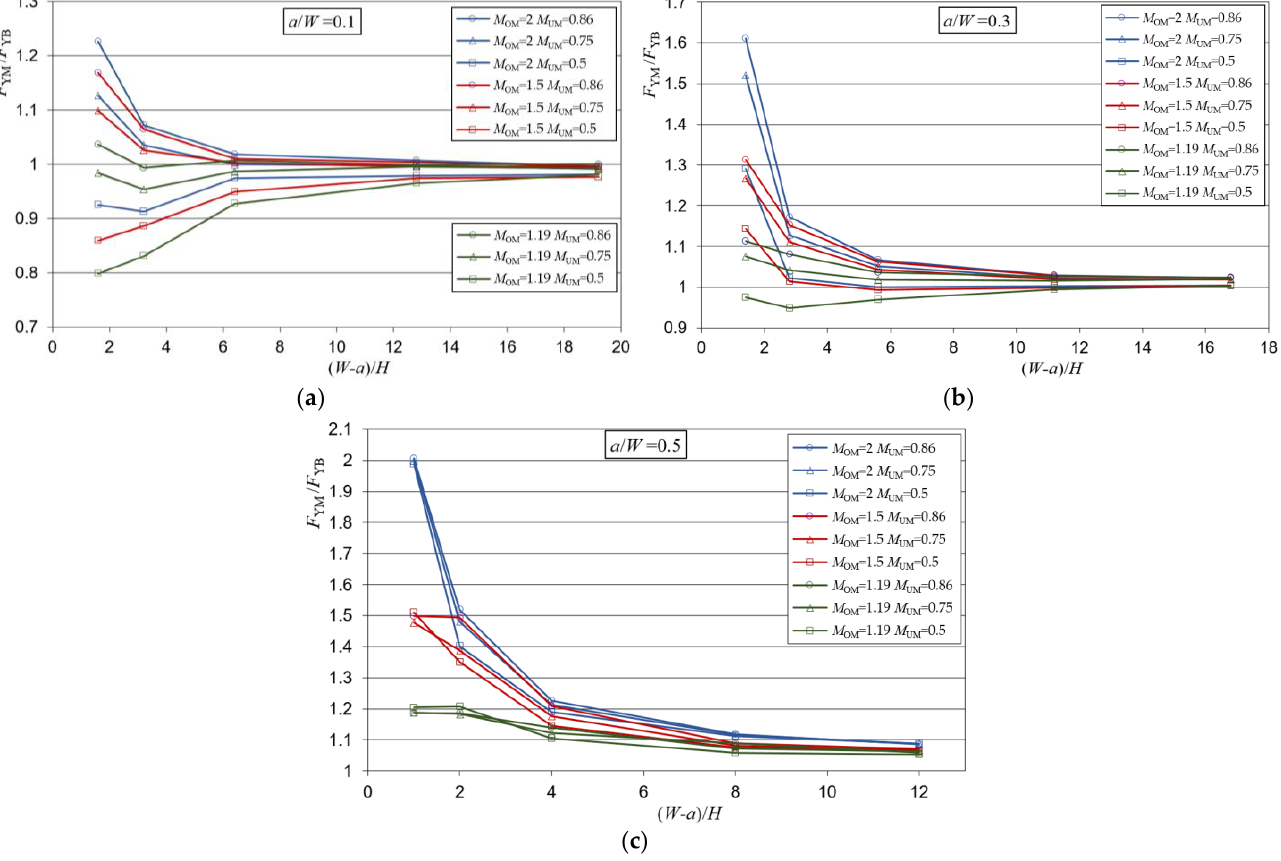
Figure 6. Mismatch yield loads for the heterogeneous weld and for a crack in the under-matched part of the weld: ( a ) shallow crack— a / W = 0.1; ( b ) medium length crack— a / W = 0.3; ( c ) deep crack— a / W =